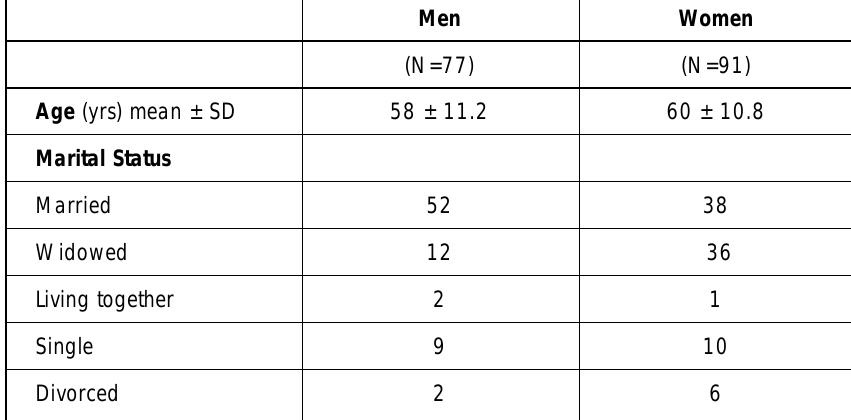
Table 1: Age and marital status versus